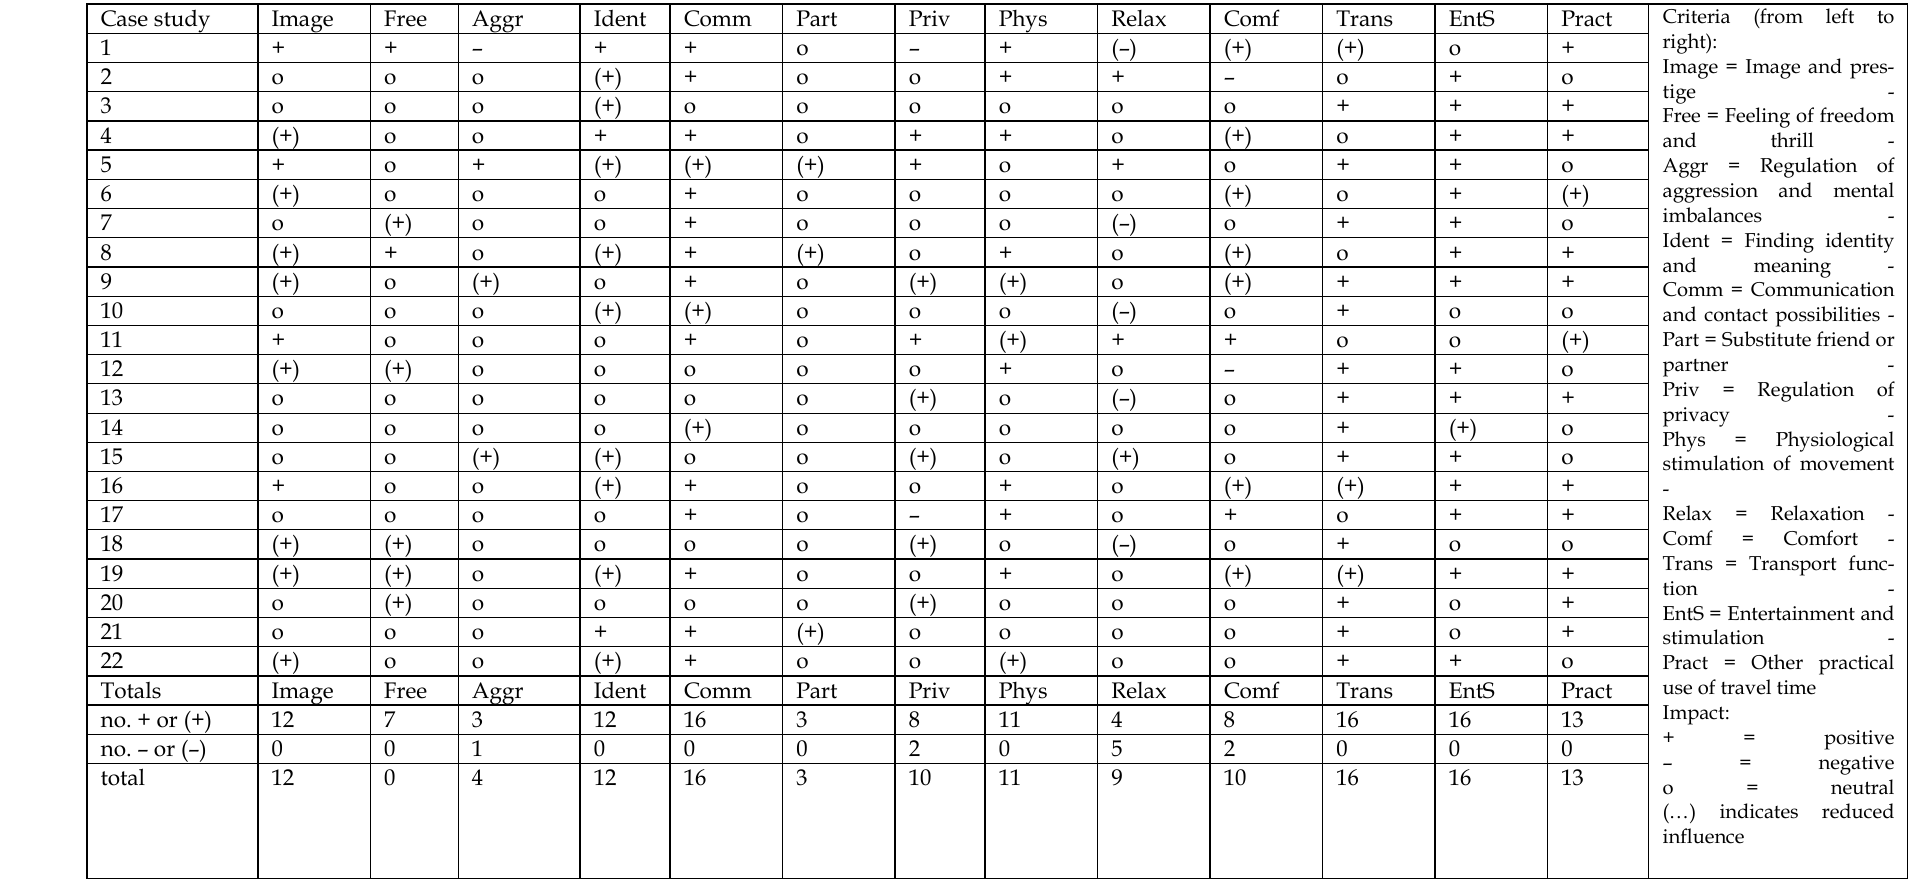
Table 5. Experiential attractiveness of the case studies (author’s depiction) Case